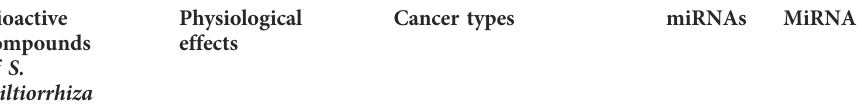
TABLE 1 Regulation of microRNAs by S. miltiorrhiza bioactive compounds in cancer progression